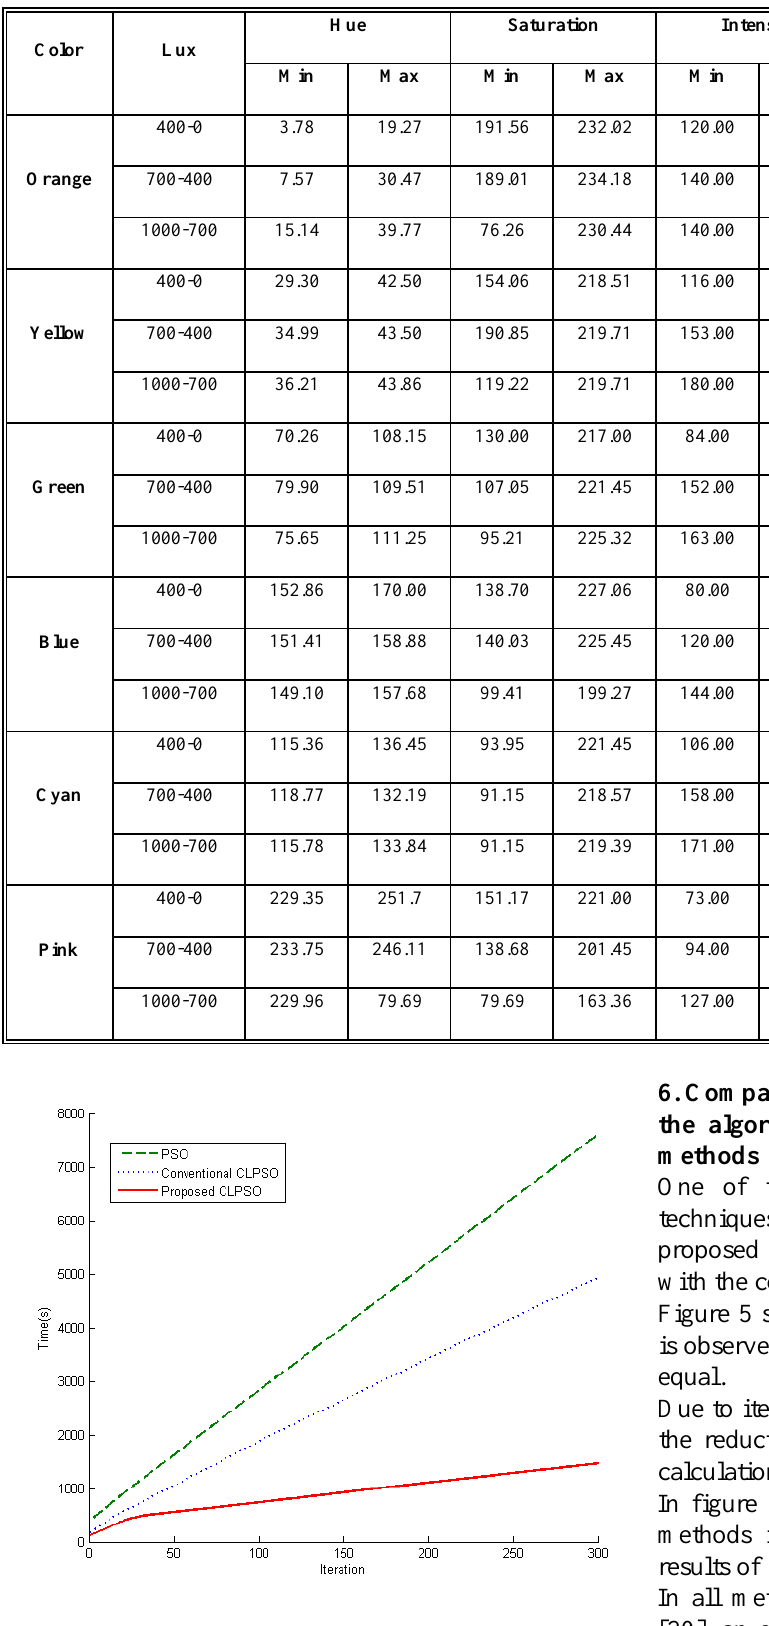
Table 4. The effect of light changes on system